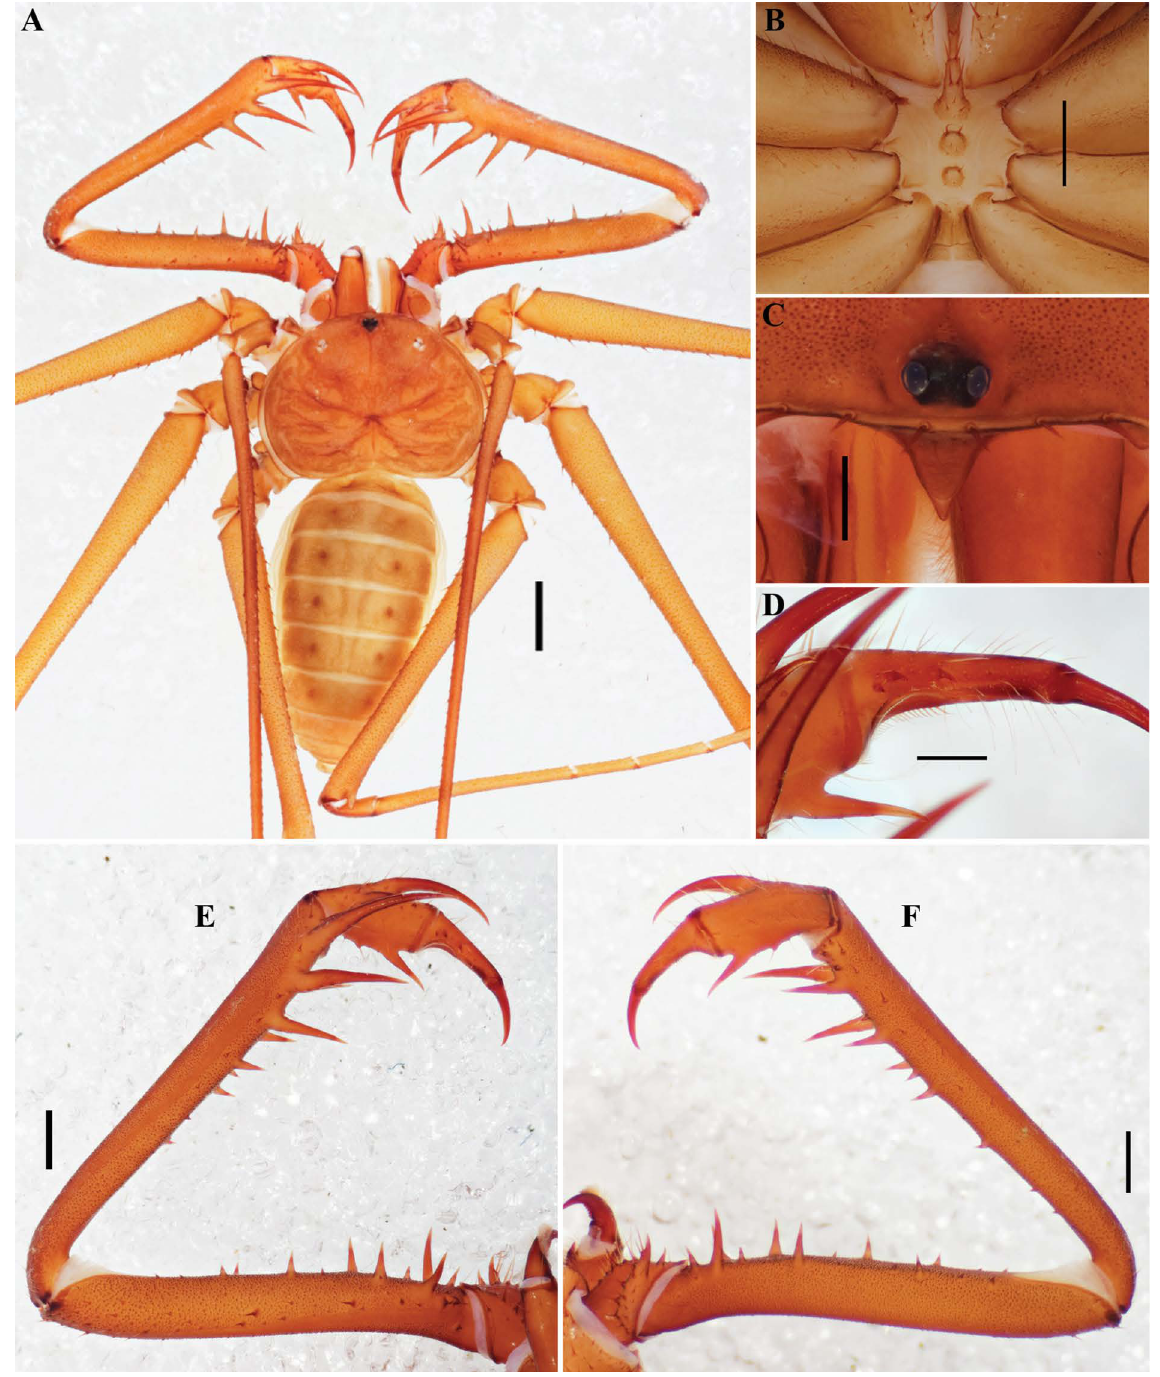
Fig. 52. Charinus carioca sp. nov. (MNRJ 9021), general morphology, ♂. A . Habitus, dorsal view. B . Sternum, ventral view. C . Frontal process. D . Pedipalp tarsus, frontal view. E . Pedipalp, dorsal view. F . Pedipalp, ventral view. Scale bars: A–B, E–F = 1 mm; C–D = 0.5